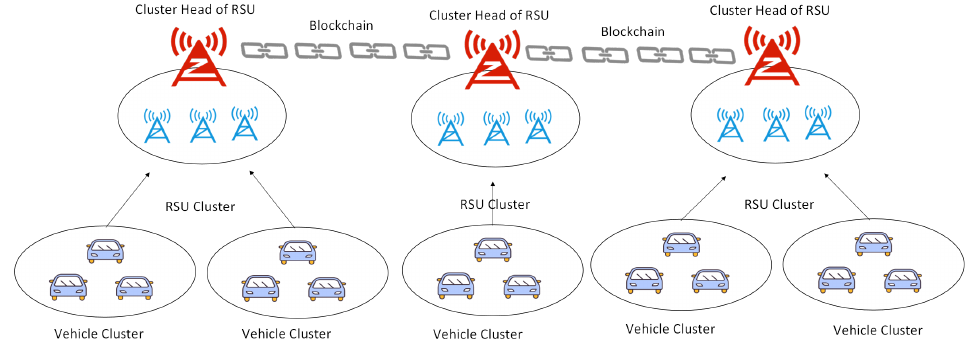
Figure 7. Heterogeneous resource scheduling scheme based on blockchain proposed in